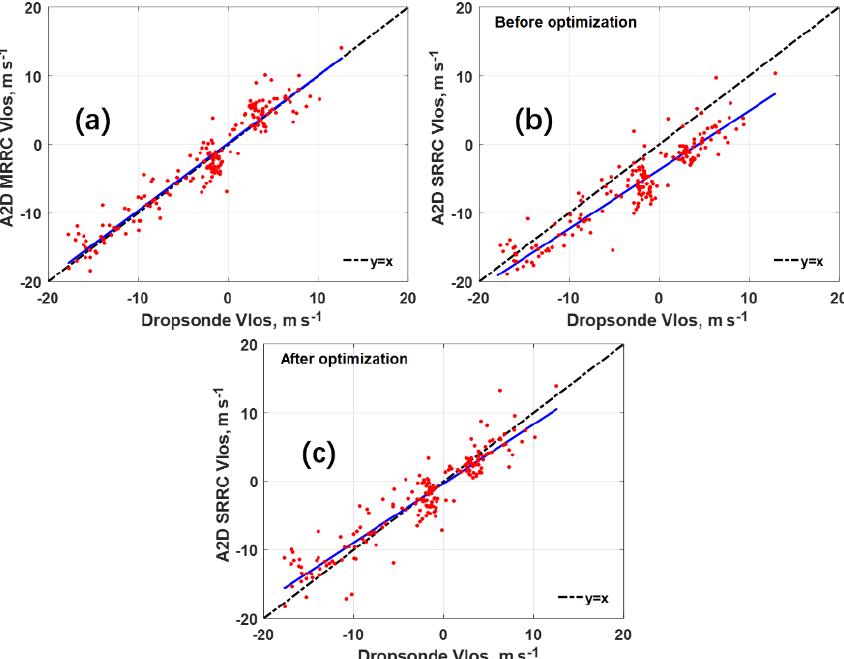
Figure 10. LOS velocity (Vlos) comparison obtained from (a) dropsonde and A2D Rayleigh channel measurement with MRRC (b) drop- sonde and SRRC before FPI optimization, and (c) dropsonde and SRRC after FPI optimization. Table 5. Statistical comparison between results from dropsonde, A2D Rayleigh channel measurement, and SRRC before and after FPIs optimization during 2016 campaign. Statistical parameters Dropsonde Dropsonde to A2D SRRC Dropsonde to A2D SRRC to A2D MRRC before FPI optimization after FPI optimization Number of compared data pairs 185 190 190 Correlation coefficient, r 0.95 0.93 0.94 Slope 0.99 0.86 0.86 Intercept, ms − 1 0.19 − 3 . 70 − 0 . 32 Mean bias, ms − 1